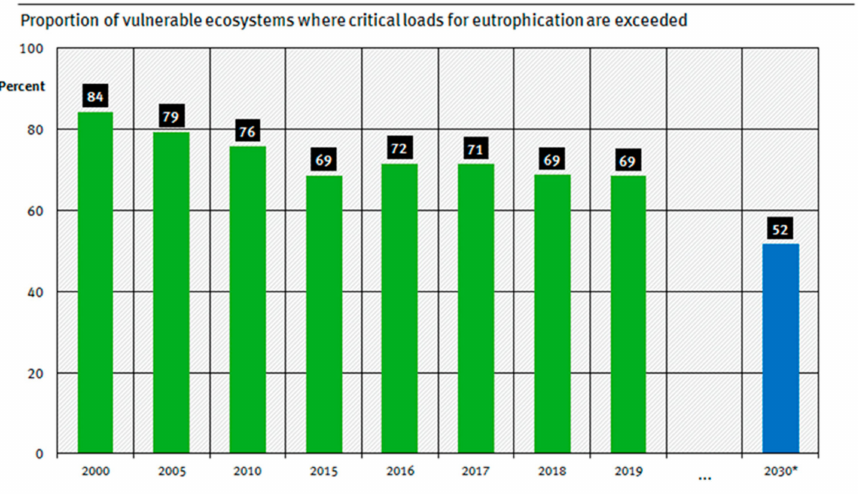
Figure 7. Results of CL exceedance calculation for Germany. Source: